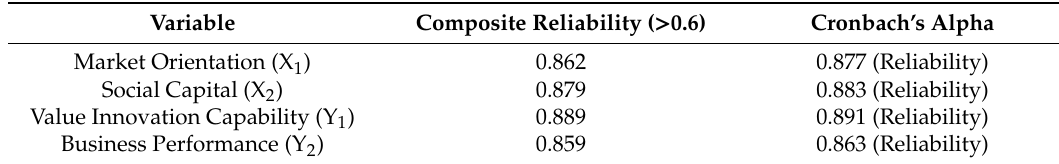
Table 3. Composite reliability and Cronbach’s